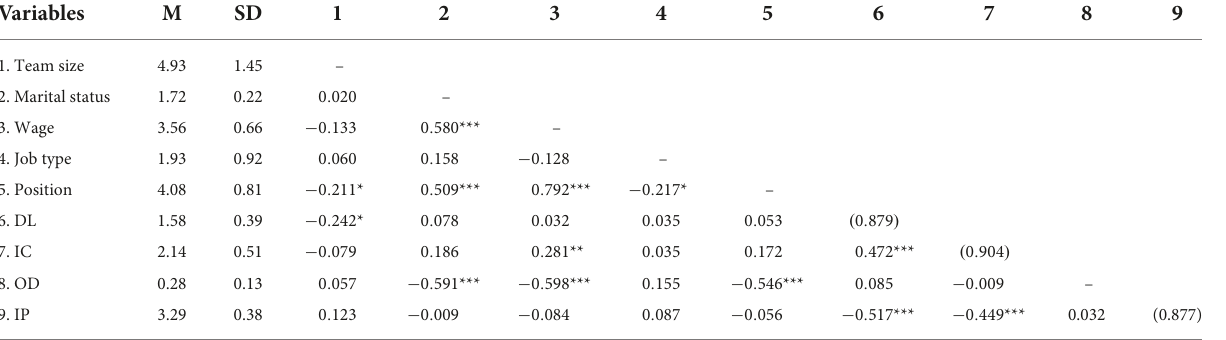
TABLE 3 Summary of regression analysis